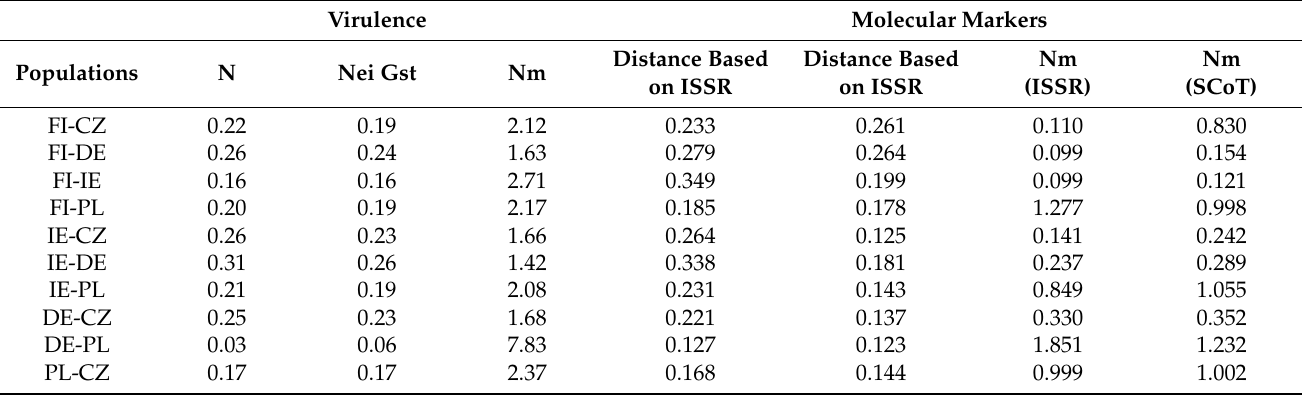
Table 3. Nei’s (N) distance, Nei’s standardized coefficient of gene differentiation (Nei Gst) and gene flow (Nm) between analysed B. graminis f. sp. avenae populations.